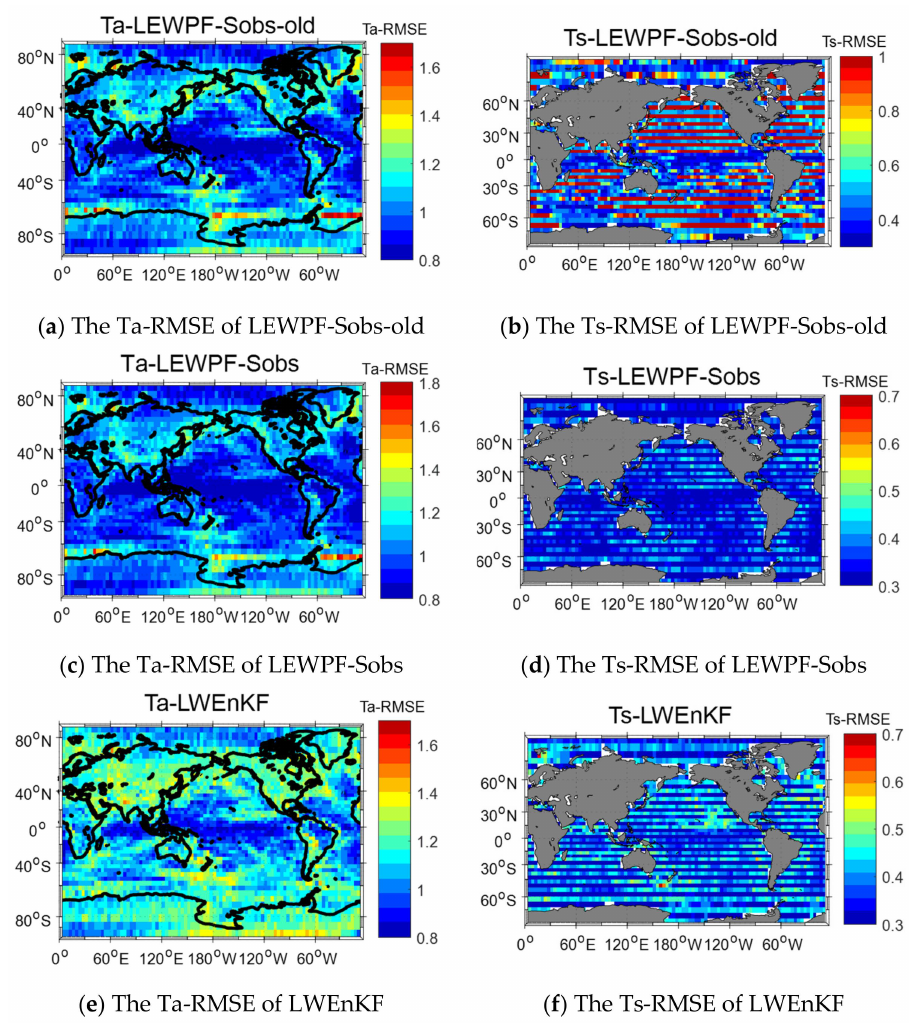
Figure 9. The spatial distribution of annual average RMSE of panel ( a , c , e ) the atmospheric temper- ature ( T a ) and the RMSE with respect to LEWPF-Sobs-old, LWEnKF and LEWPF-Sobs. The panel ( b , d , f ) are similar to panel ( a , c , e ) but for the ocean temperature ( T s ) use the spare